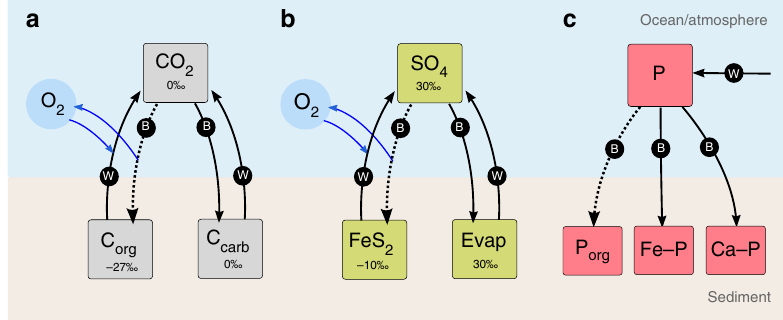
Fig. 2 Diagram of key processes in the COPSE model. a Carbon cycle. Hydrospheric CO 2 is transferred to sediments as organic C or carbonate by burial (B). Sedimentary C is returned to the ocean/atmosphere via weathering and metamorphism (W). Buried organic C is isotopically lighter than the carbon it is derived from. Burial of reduced organic carbon results in a net source of O 2 , whereas oxidative weathering of sedimentary organic carbon consumes O 2 . b Sulphur cycle. Burial of reduced pyrite is a net source of O 2 , whereas oxidative weathering of sedimentary pyrite consumes O 2 . c Oceanic phosphorus (P) cycle. Dissolved, bio-available P is delivered to the ocean by chemical weathering via rivers, and is buried either as organic phosphorus, or with iron or calcium minerals. Dashed lines show burial processes that are in fl uenced by bioturbation (but are not considered so in the baseline